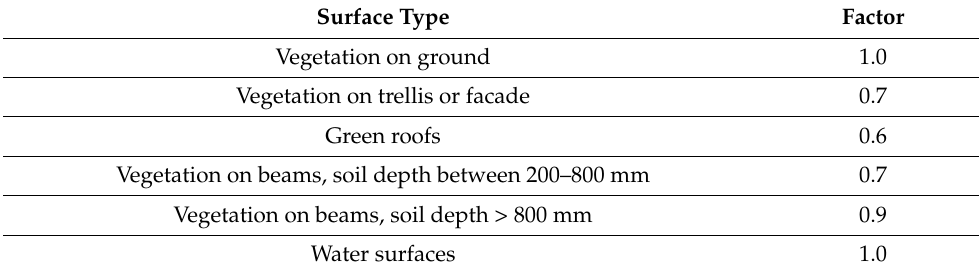
Table 3. Green space factor